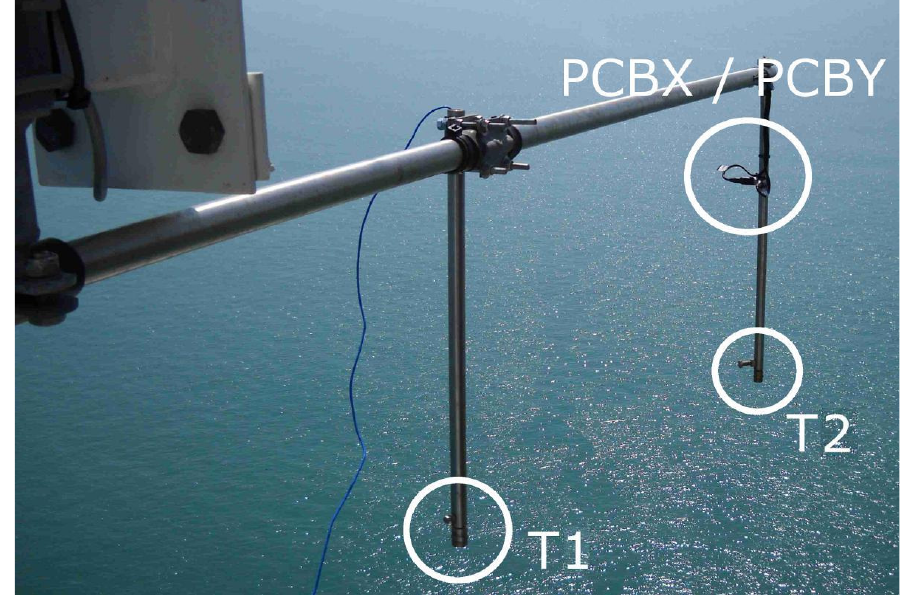
Figure 3. Installation of two parallel pressure sensors (T1 and T2) at the FINO3